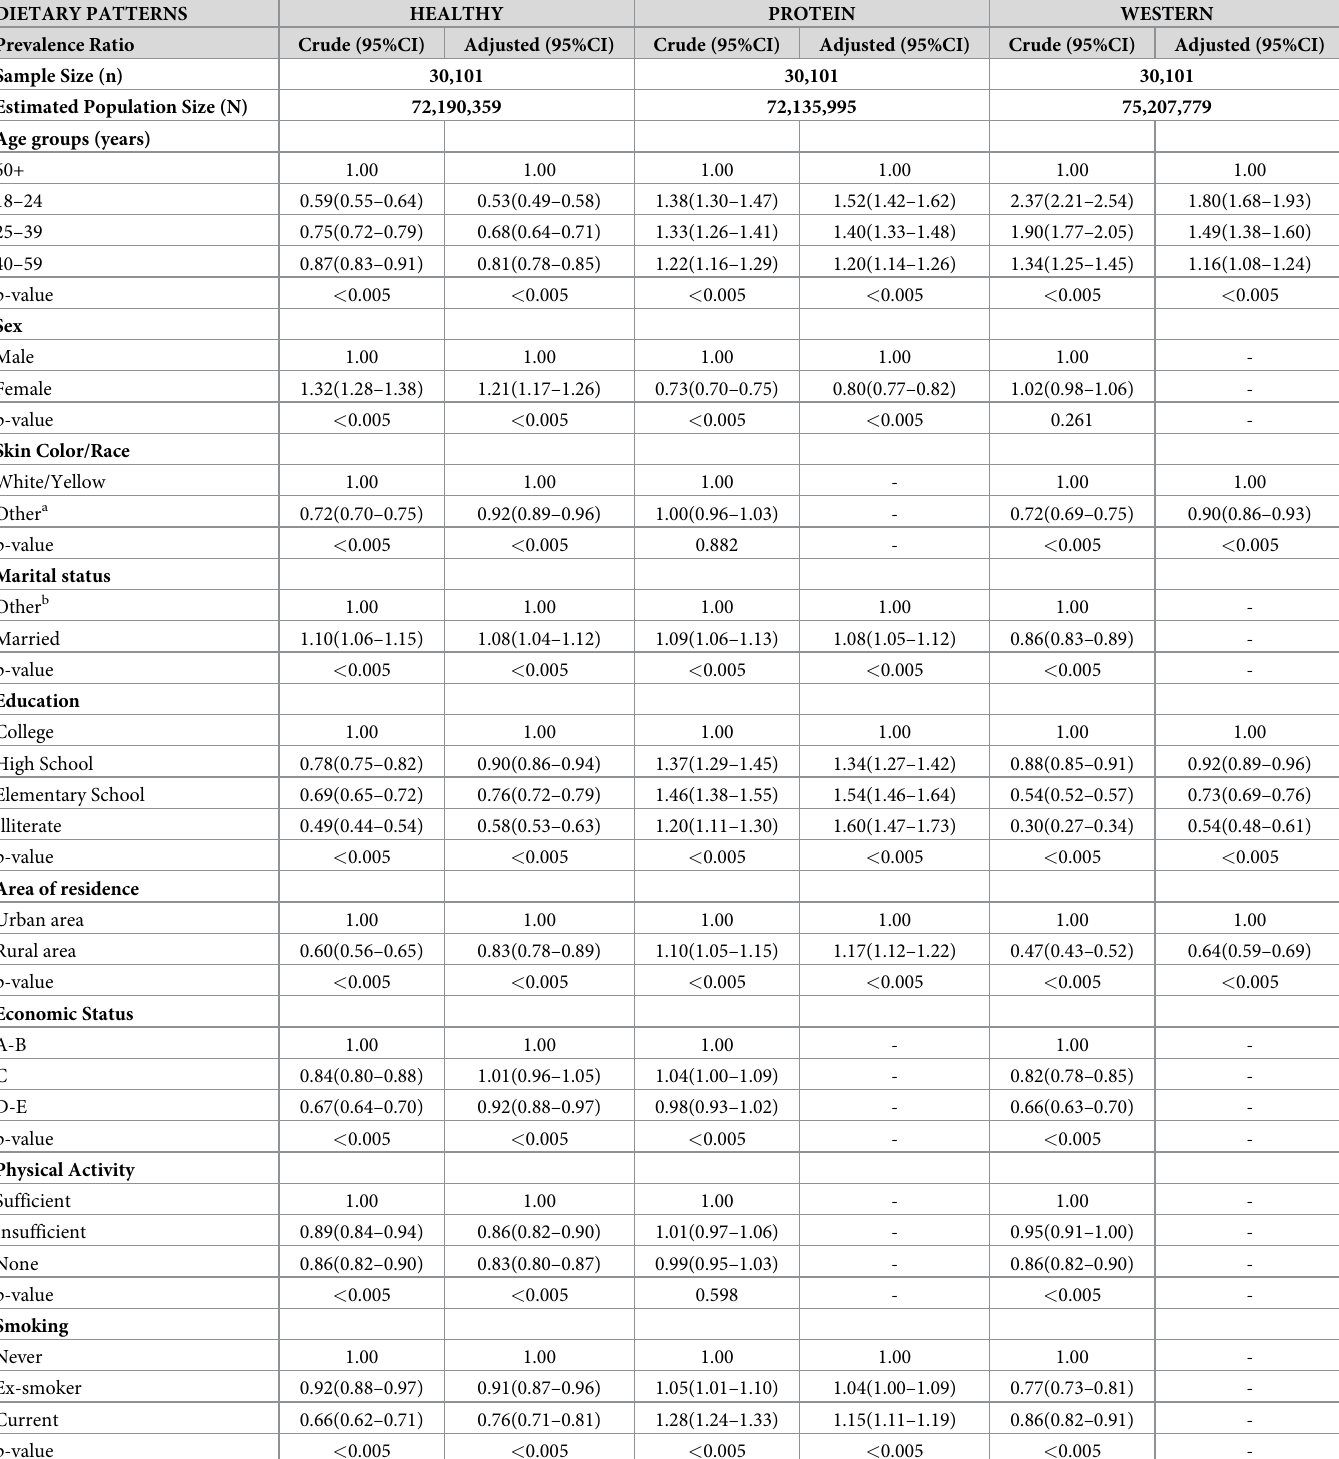
Table 3. Associations between health, lifestyle, sociodemographic characteristics and countrywide Brazilian dietary patterns. Comparison between first and fourth